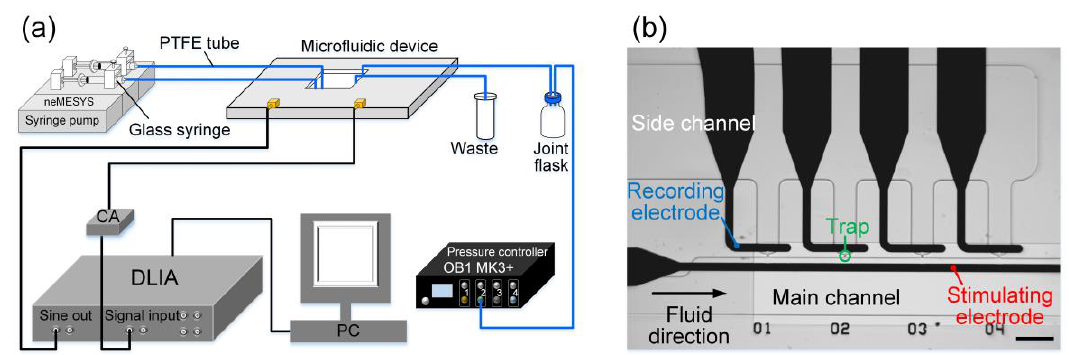
Figure 16. Experimental setup of electrical impedance measurement ( a ) and micrograph of the microfluidic device ( b ). Scale bar is 100 µ